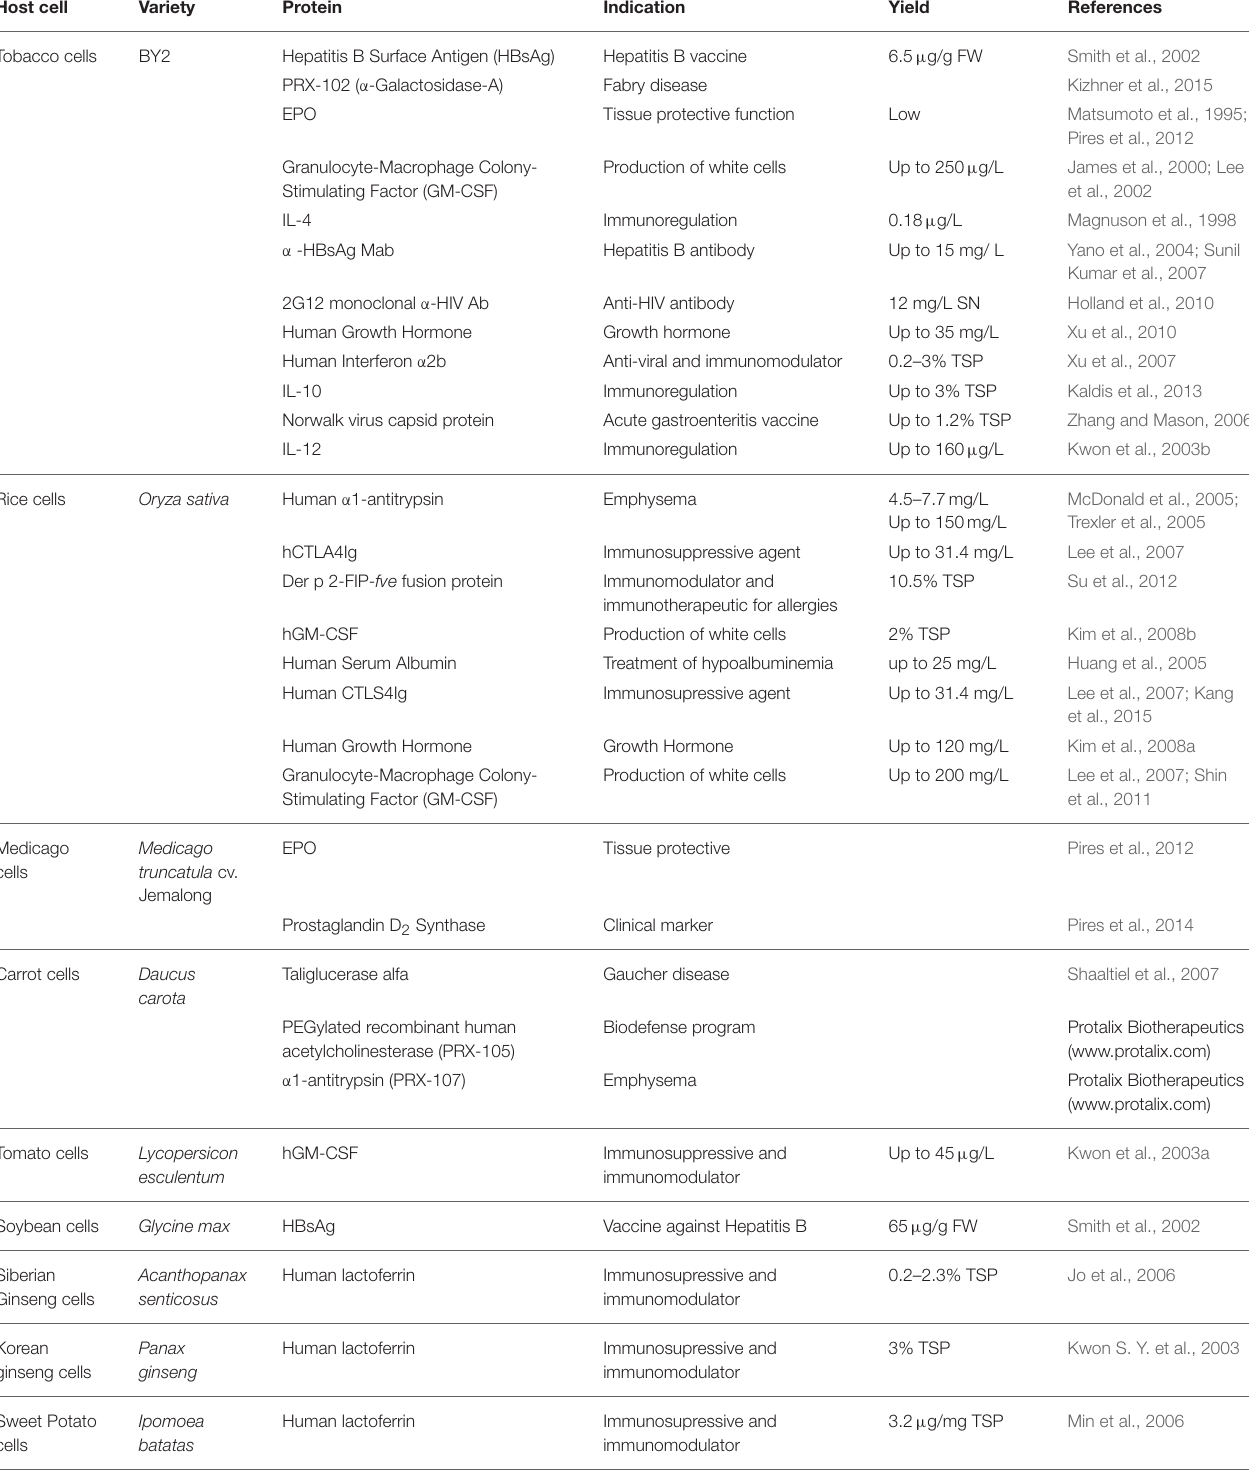
TABLE 1 | Biopharmaceuticals produced in different plant cell suspension